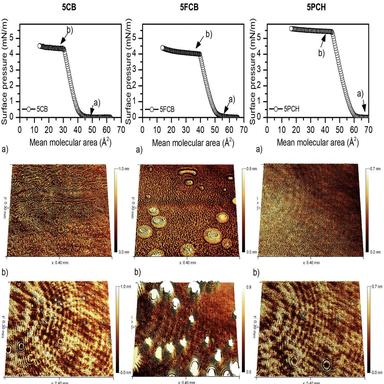
The surface pressure (π)-Mean molecular area (A) isotherms for 5CB (left column), 5FCB (central column), and 5PCH (right column) with corresponding 3D BAM images of uncompressed (a) and compressed (b) monolayer.